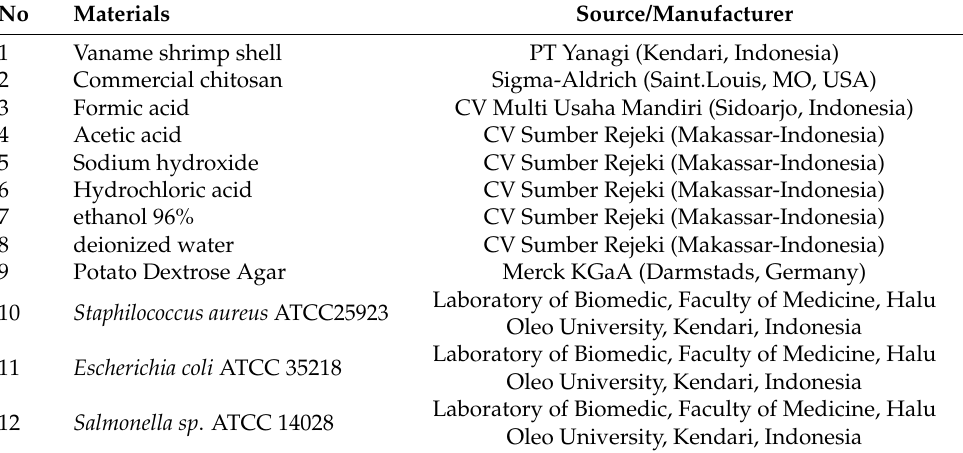
Table 1. The materials of